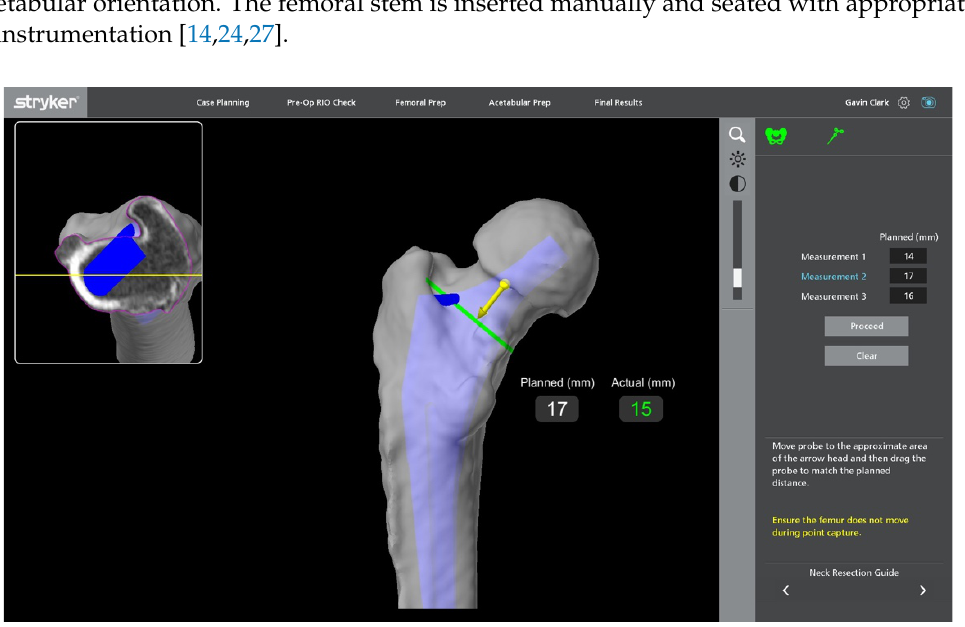
Figure 8. Intra-operative image templating neck resection (green line). The blue area is a registration point, and the yellow arrow is the starting point for probe registration.